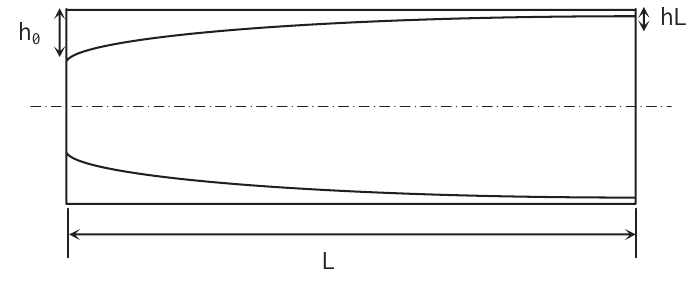
Fig. 2. Cross-section of exponential-tapered